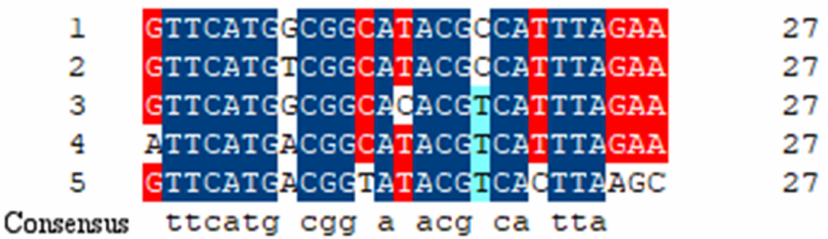
Figure 3. Nucleotide sequence alignment of the five different repeat sequences. The “consensus” line represents the same